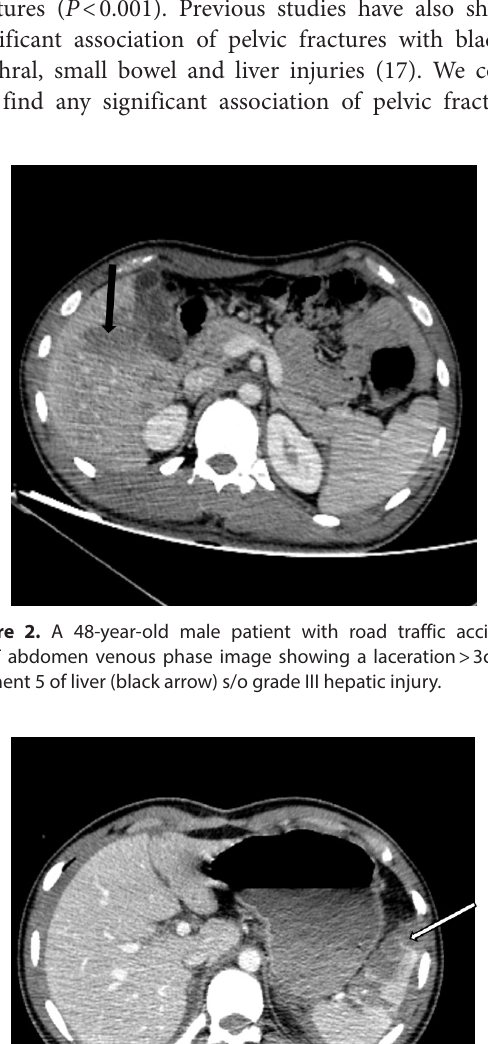
Table 4. Relationship between spinal/pelvic fractures and bladder/bowel injuries Bladder/urethral